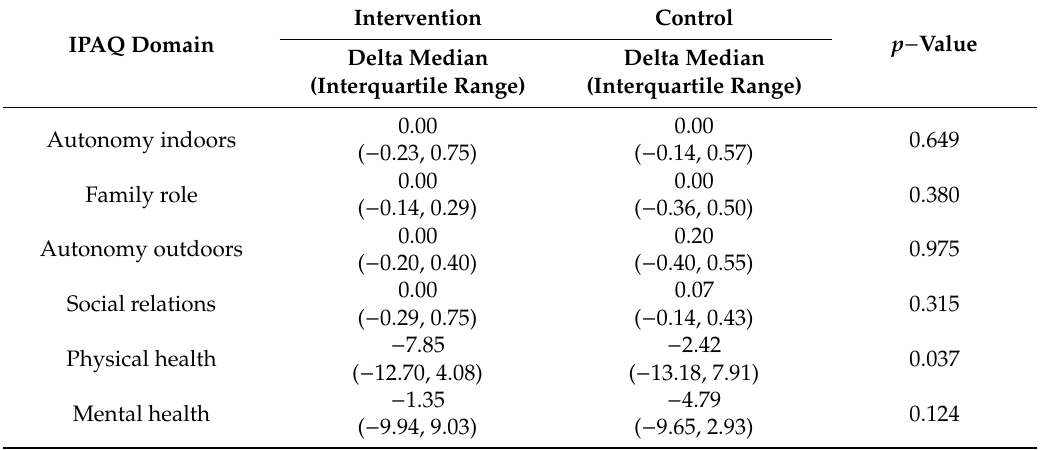
Table 4. Comparison of di ff erences in health scores of intervention group and control group.